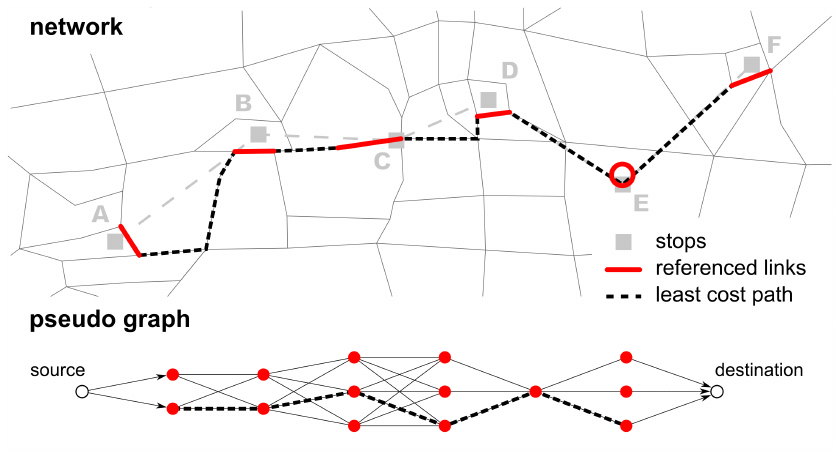
Figure 5. Least-cost path from the source to the destination on the pseudo graph: The nodes of this path represent the link candidates for the stops in the